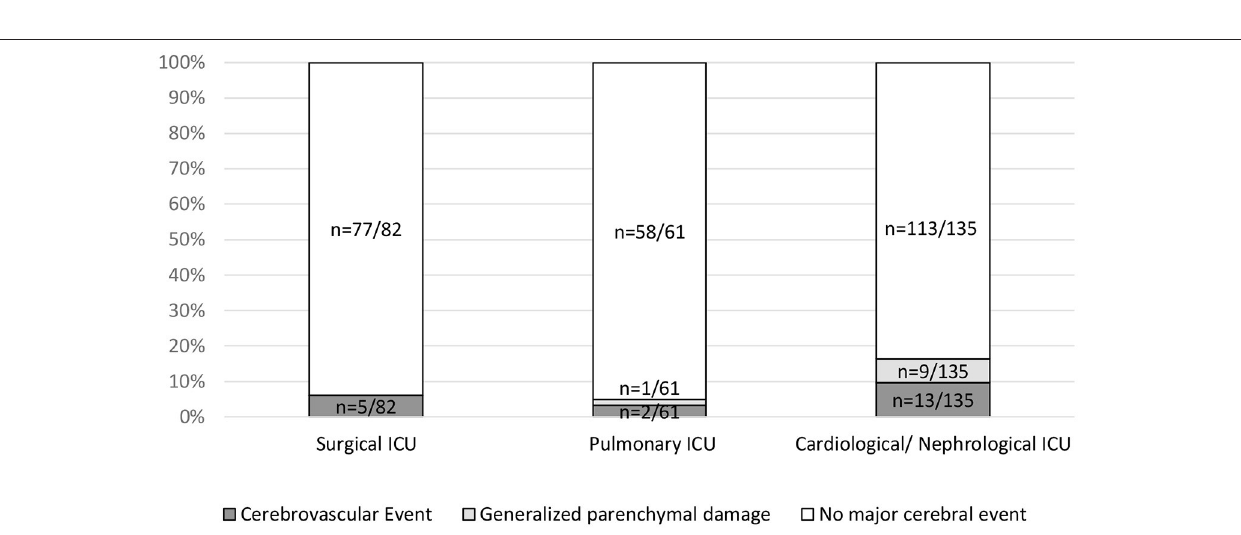
FIGURE 3 | Association of major events with referring ICU. Referring ICUs (Surgical ICU, Pulmonary ICU and Cardiological/Nephrological ICU) were compared using a contingency table for the parameters cerebrovascular events ( p = 0.25), generalized parenchymal damage ( p = 0.03), and major events ( p = 0.02).